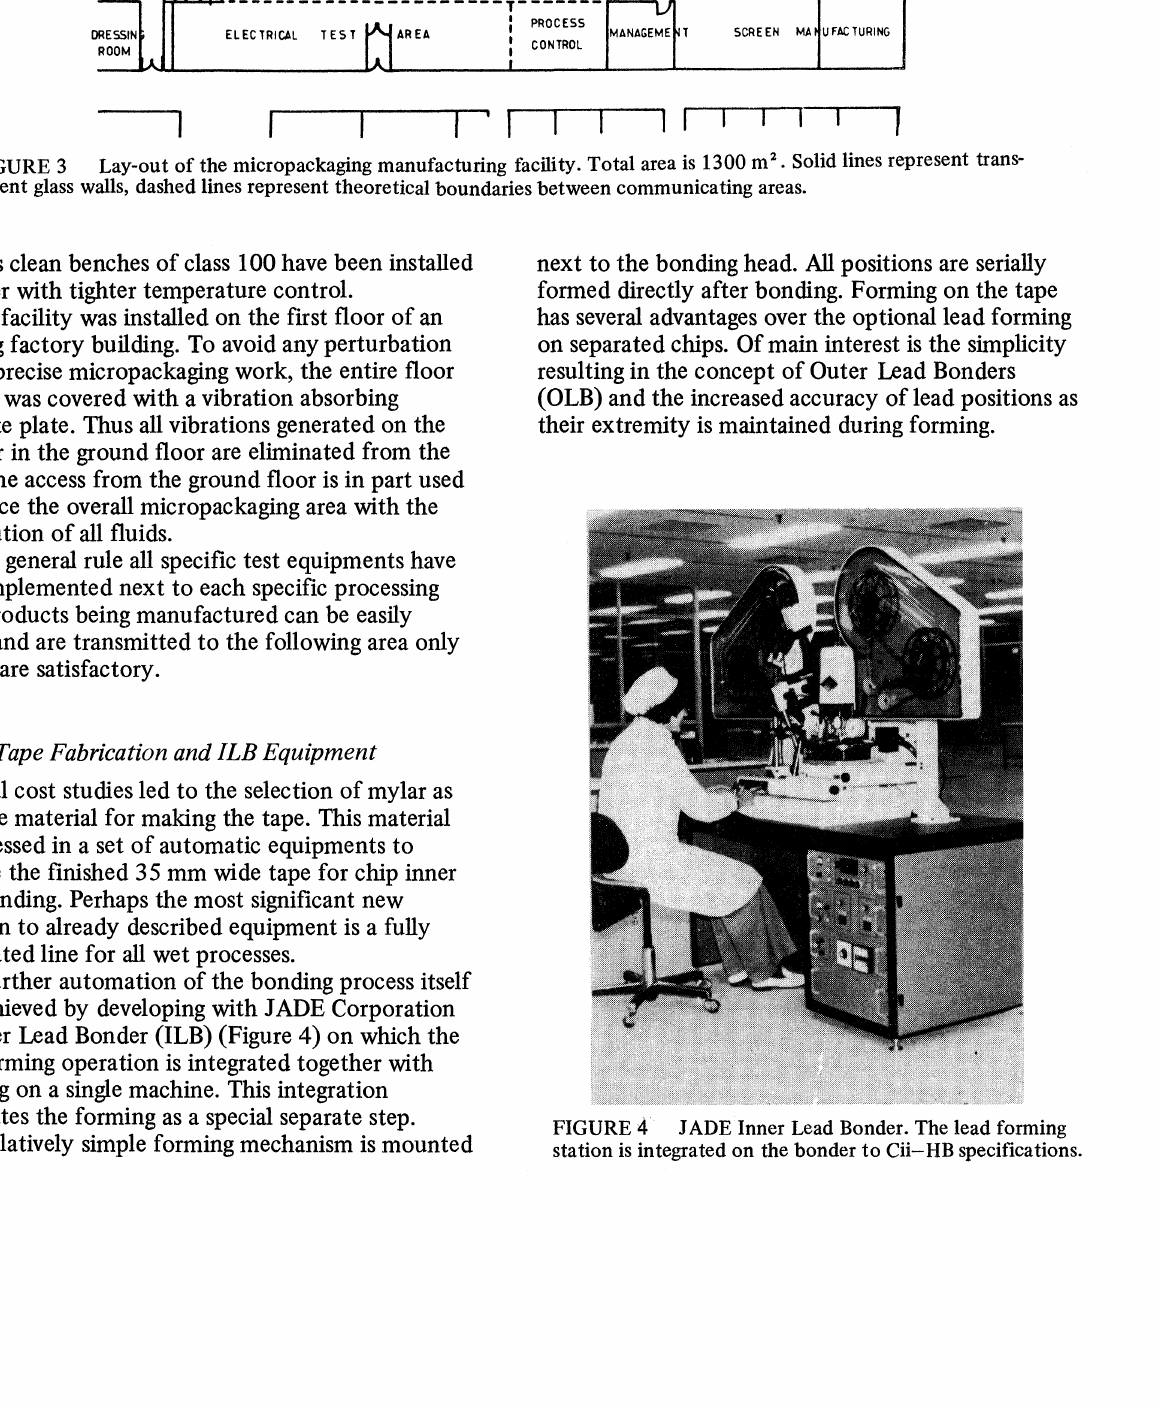
JADE Inner Lead Bonder. The lead forming station is integrated on the bonder to Cii-HB